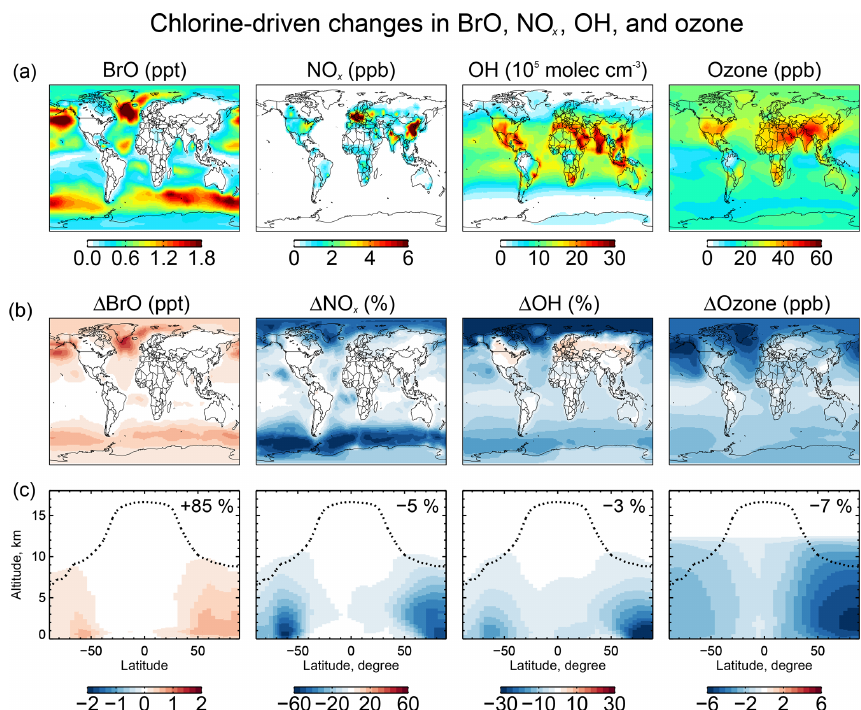
Figure 9. Effects of tropospheric chlorine chemistry on BrO, NO x , OH, and ozone concentrations. Panel (a) shows the annual mean surface concentrations of BrO, NO x , OH, and ozone simulated in our standard model including tropospheric chlorine chemistry. Panels (b) and (c) show the changes in annual mean mixing ratios and concentrations due to tropospheric chlorine chemistry, as determined by the difference with a sensitivity simulation including no Cl y production and cycling. Panel (b) shows the changes in surface air concentrations and panel (c) shows the changes in zonal mean mixing concentrations as a function of latitude and altitude. Black dashed lines indicate the tropopause. Numbers in (c) show the global tropospheric mean